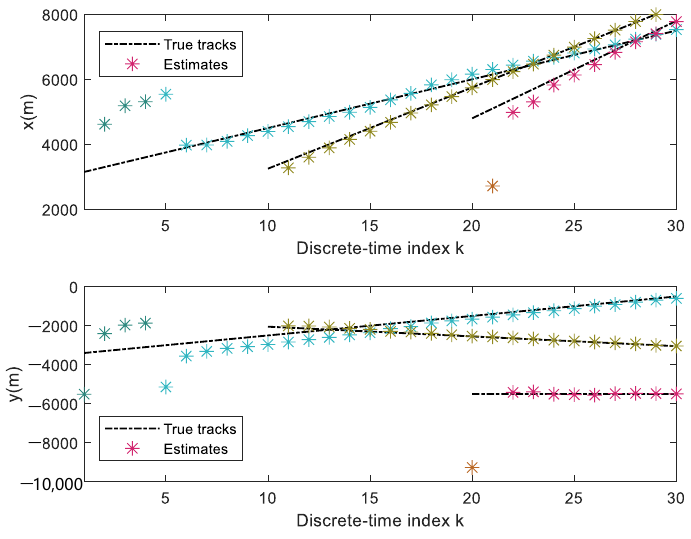
Figure 11. Scenario 2: True and CAR estimated x and y coordinates versus time. The averaged OSPA distance ( p = 1 and c = 10,000 m) and OSPA ( 2 ) distance (with the same c , p , and window length w = 10) are shown in Figure 12a,b, respectively.